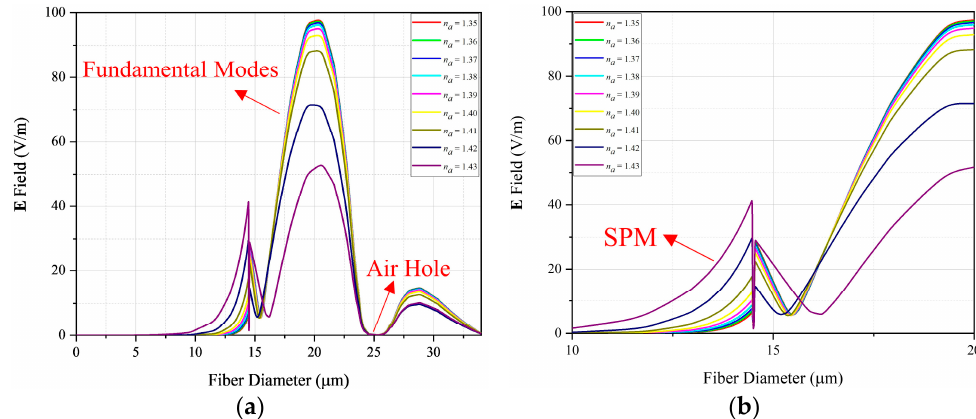
Figure 6. One-dimensional E -field for sensor with SiO 2 defect for: ( a ) Entire diameter; ( b ) Close to SPR.